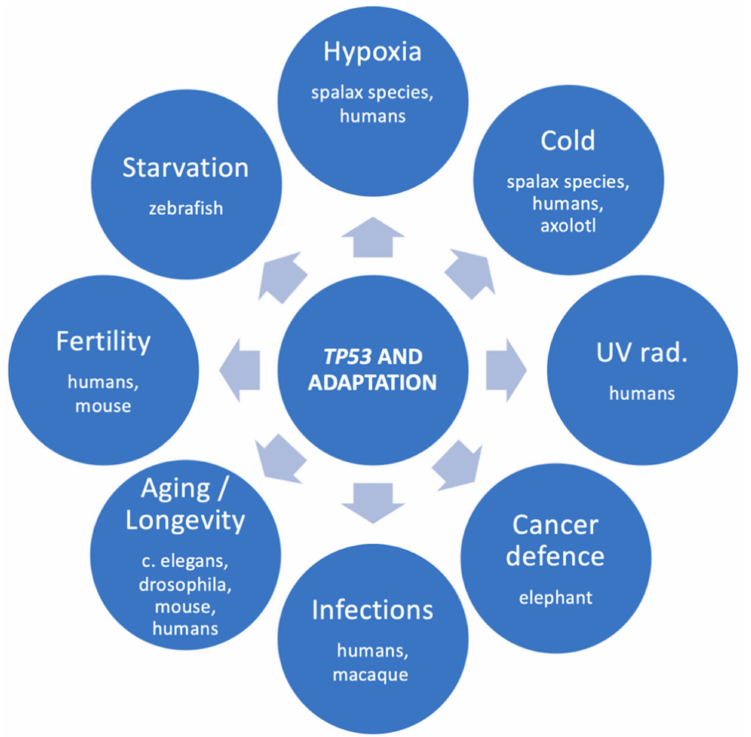
Figure 2. The multiple adaptational roles of TP53 and the species that evidence was found for each